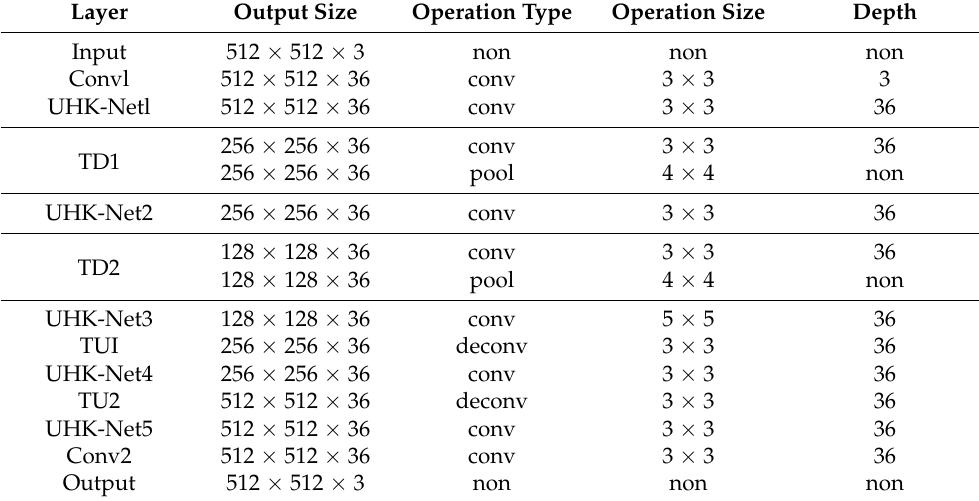
Table 2. Different parameters.